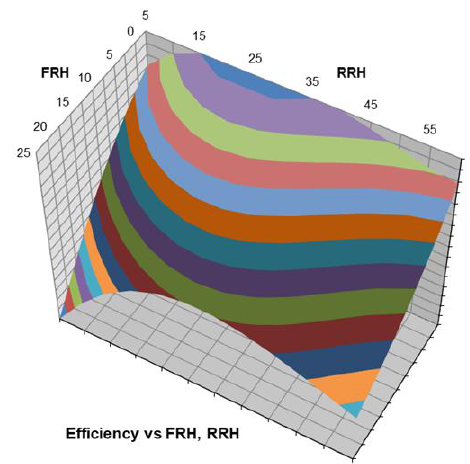
Figure 9. Efficiency vs. FRH and RRH, 3D map.